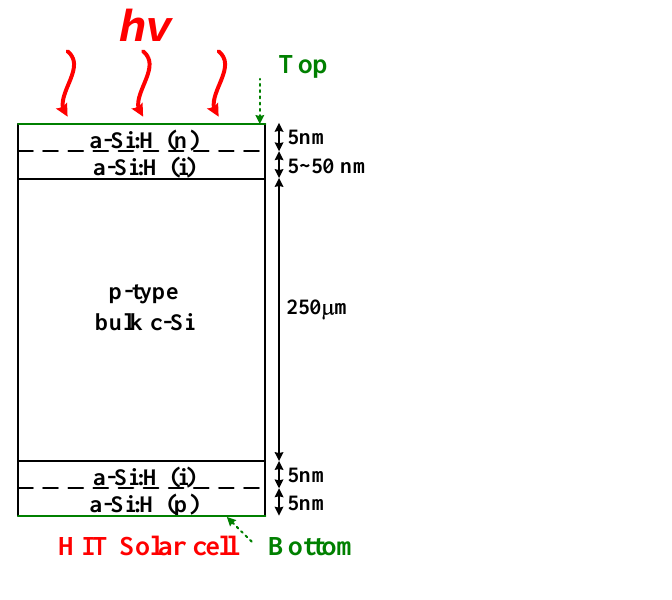
Figure 2. Current density versus voltage of the HIT solar cell on the p-type Si wafer. The V is 0.649 V, and the J is 36.63 mA/cm 2 oc sc